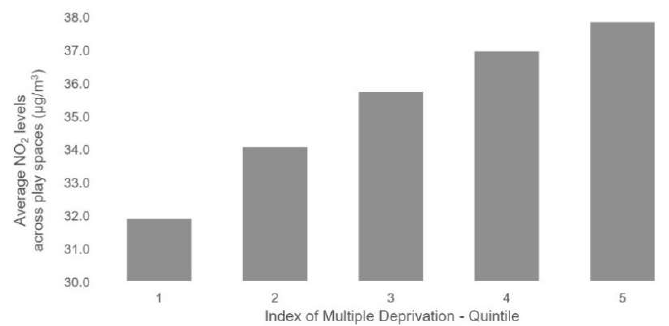
Figure 4. Average NO 2 concentrations across play spaces by deprivation quintiles (i.e., 5ths), where 1 is least deprived and 5 is most deprived.